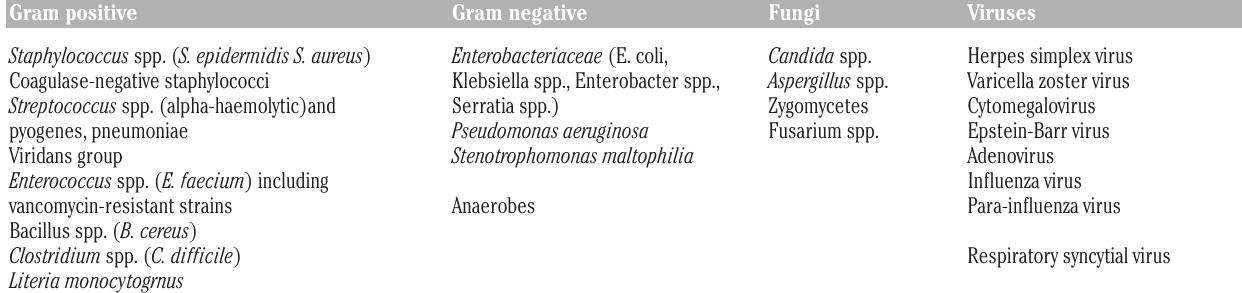
Table 4. Organisms implicated in febrile neutropenia. Gram positive Gram negative